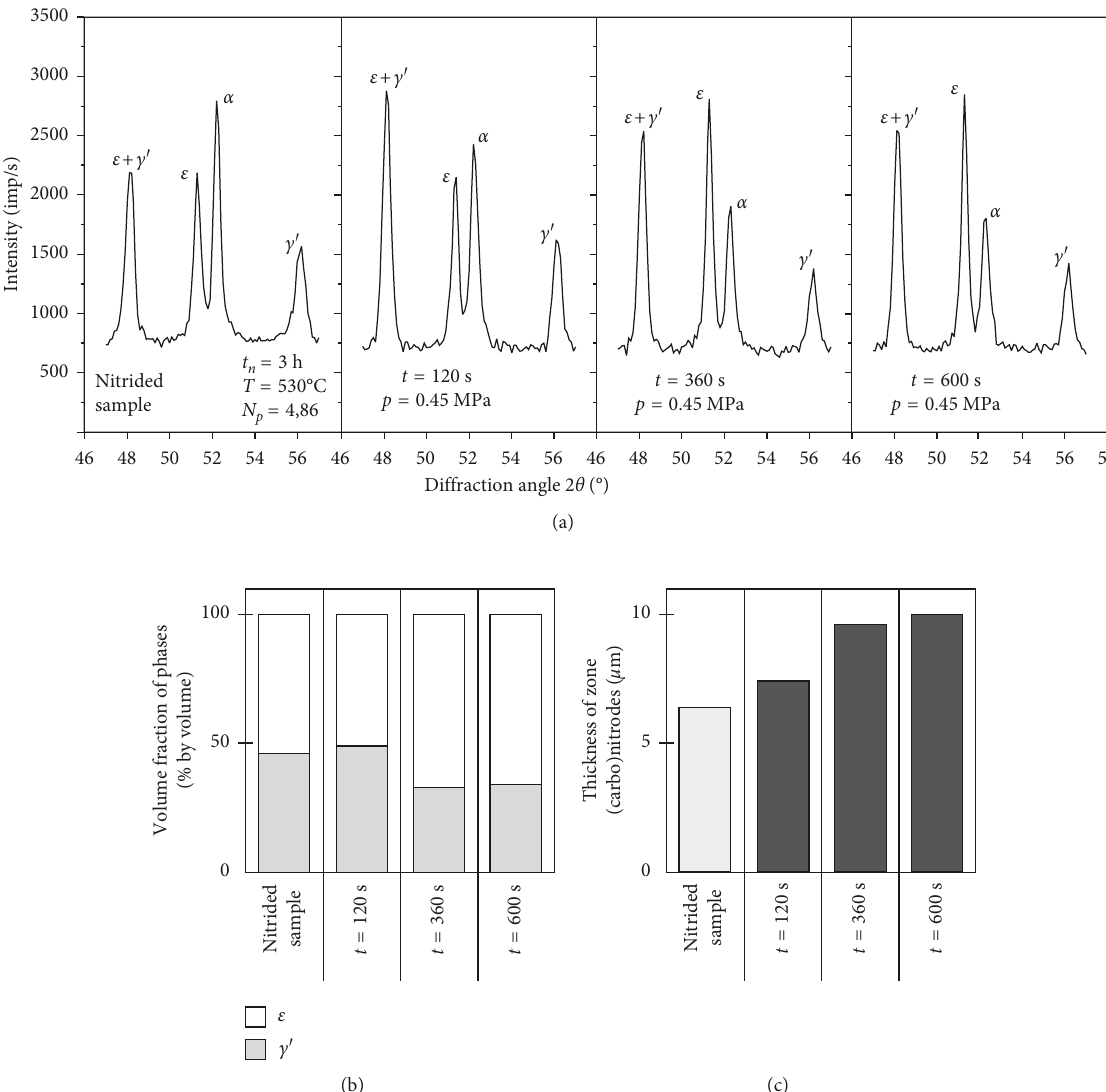
Figure 6: The phase composition of (carbo)nitride zone after nitriding process and after combined shot peening and nitriding process presented by means of X-ray diffraction pattern (a), distribution of volume contents of ε and c ′ phases in a compound layer (b), and the (carbo)nitride zone thickness